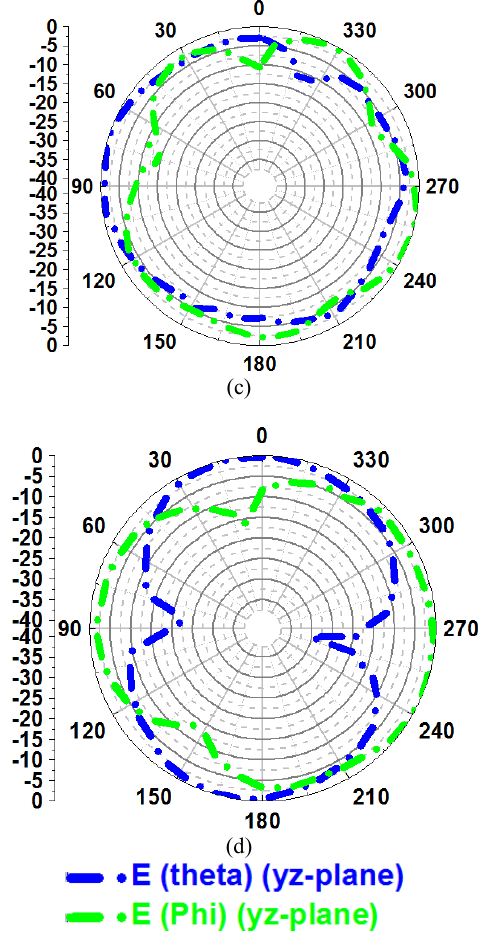
Figure 12. Measured yz-plane normalized radiation pattern for (a) 2.56, (b) 5.39, (c) 6.97 and (d) 8.08 GHz